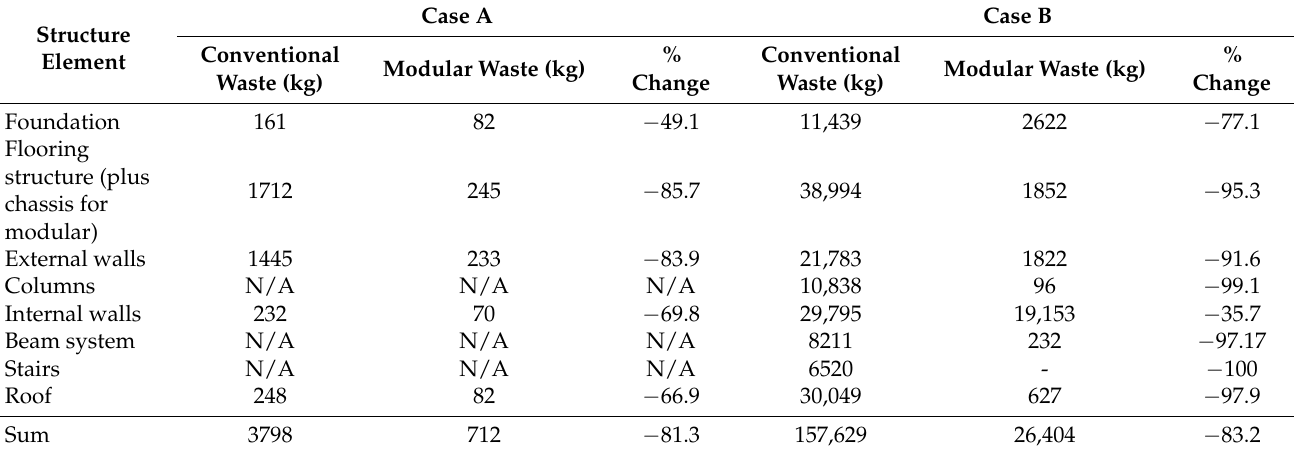
Table 9. Comparison of waste generation by conventional and modular construction for Case A and Case